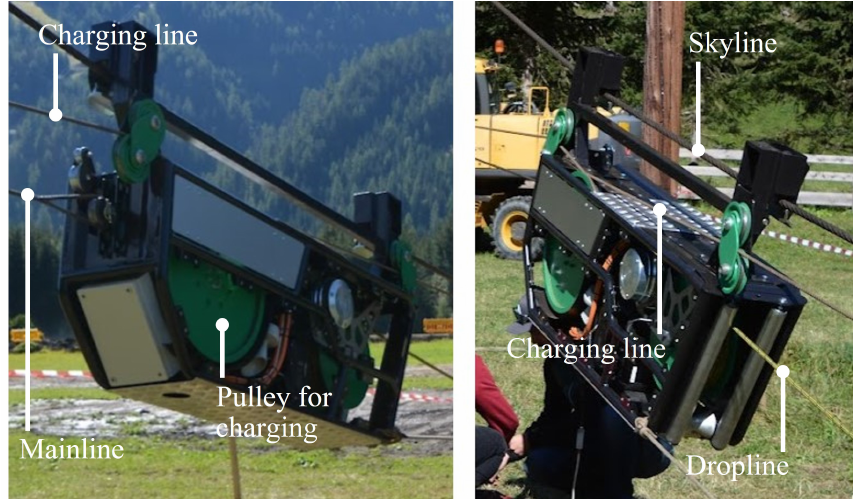
Figure 2. New concept of an electric carriage with integrated winch system by logging firm Gebr. Ladstätter KG. Images taken from